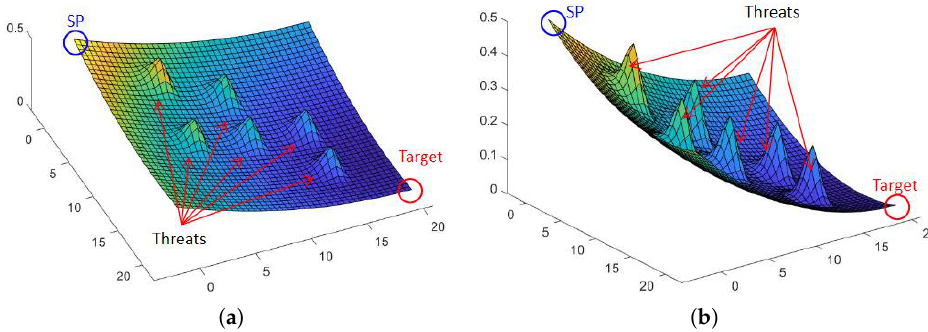
Figure 4. Example of the PFP model’s 3D surface plot: ( a ) 3D surface plot viewed from above; ( b ) 3D surface plot viewed from side.